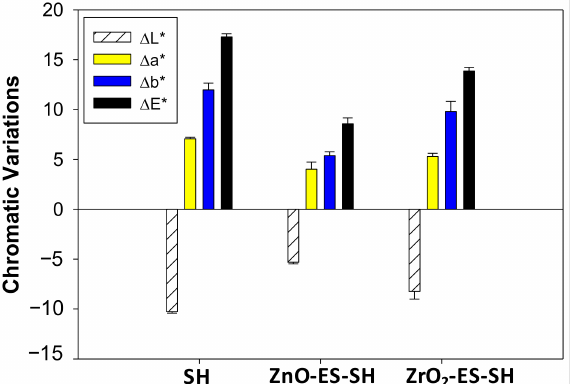
Figure 6. Chromatic variations experienced by wood specimens coated with SH, Zn-ES-SH, and ZrO 2 -ES-SH after ultraviolet (UV) irradiation (500